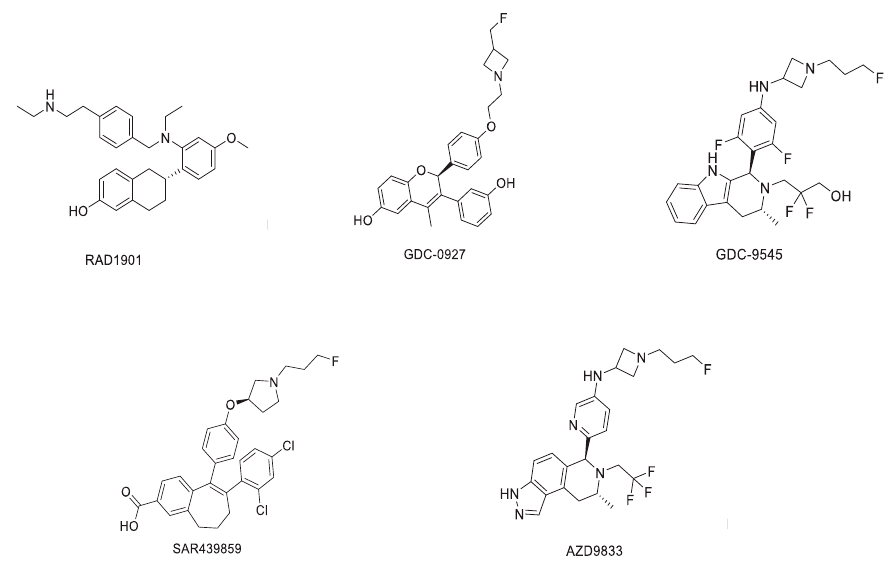
Figure 3. Structures of oral SERDs with a basic side